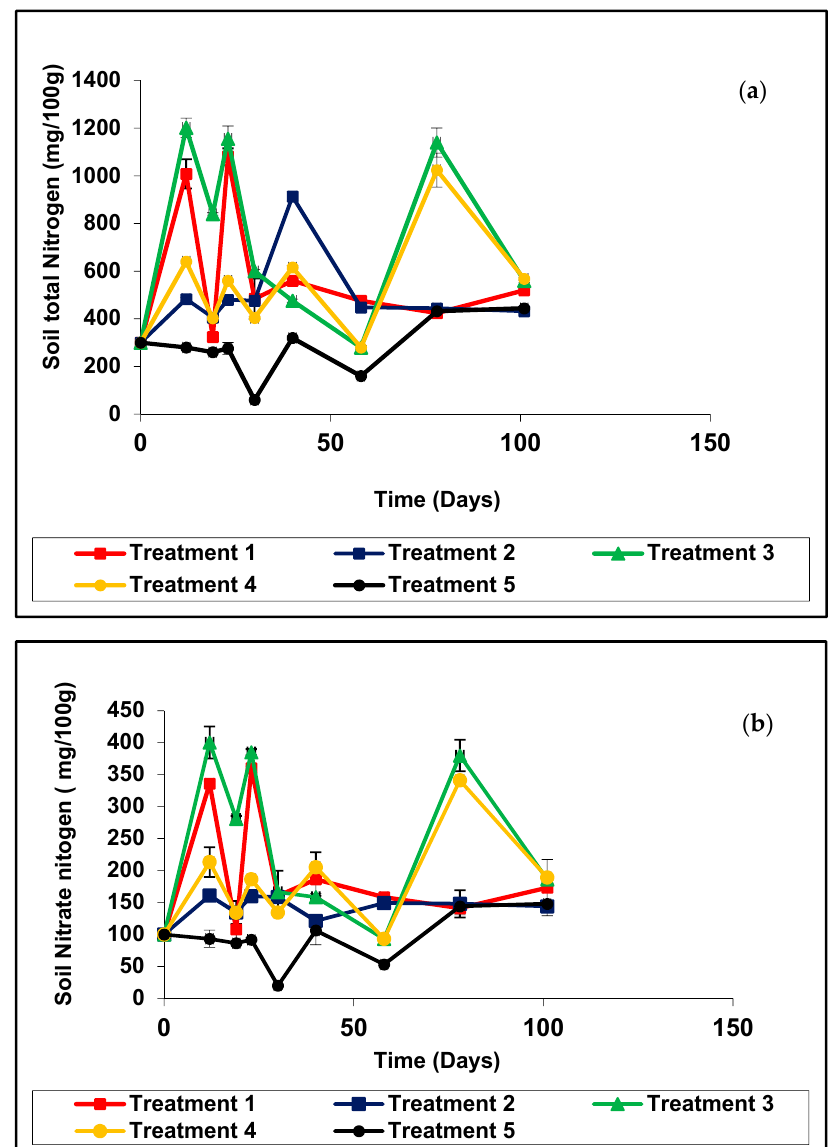
Figure 2. Variation of ( a ) total nitrogen in soil with different treatments; ( b ) nitrate nitrogen in soil with different treatments in the pot experiment .